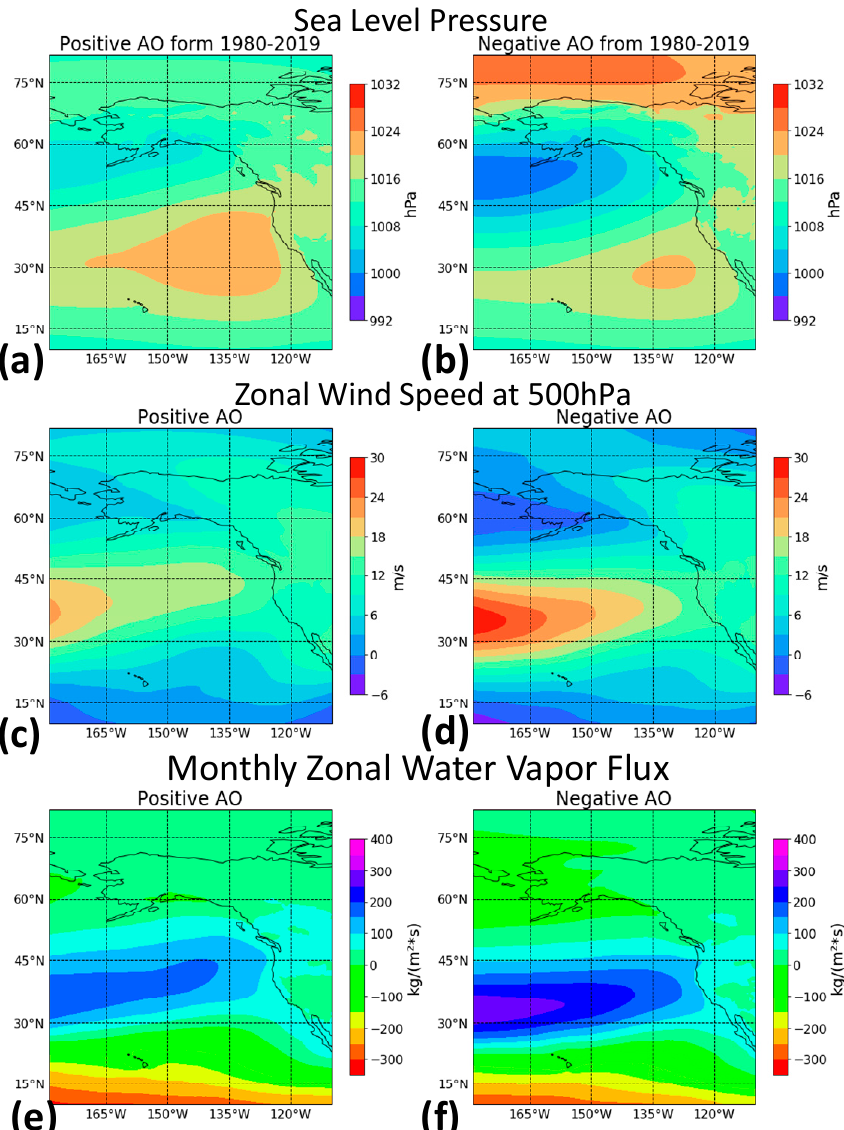
Figure 5. Composite ( a , b ) SLP , ( c , d ) 500 hPa zonal wind speed, and ( e , f ) vertically integrated zonal water vapor flux of all top positive (>+1.5) and top negative (< − 1.5) AO months from October through April during 1980–2019.